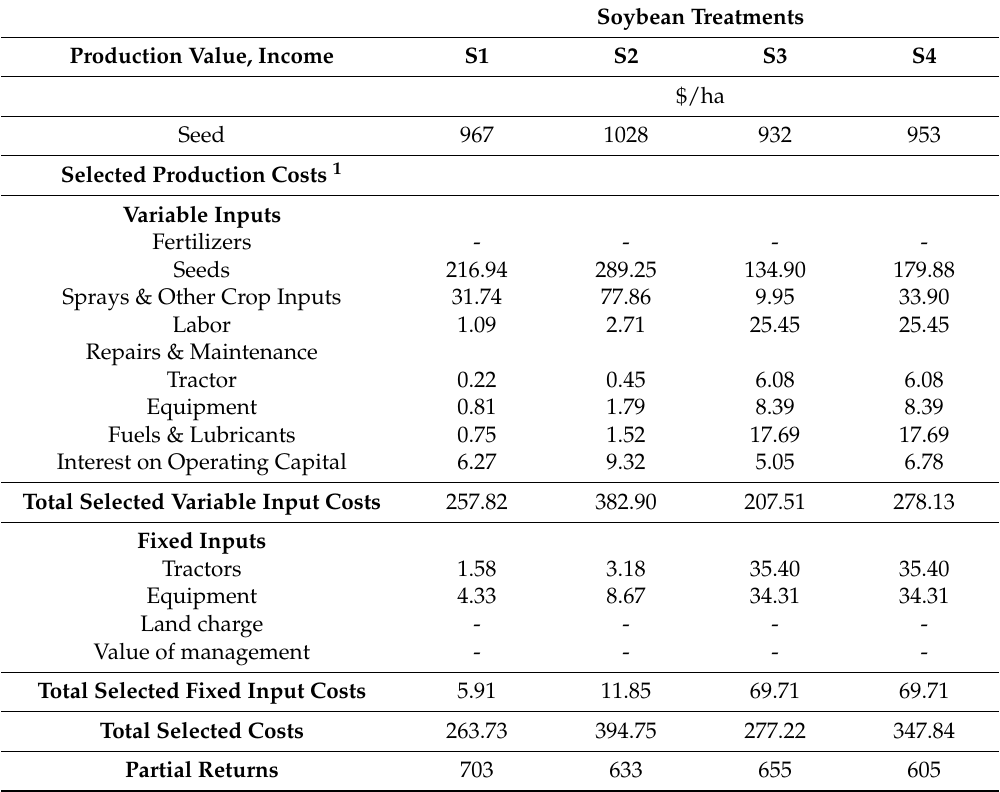
Table 8. Income, selected costs, and partial returns for conventional soybean with recommended management (S1) and high input management (S2); and organic soybean with recommended management (S3) and high input management (S4) at a Research Farm in central NY averaged across the 2015 and 2016 growing seasons 1